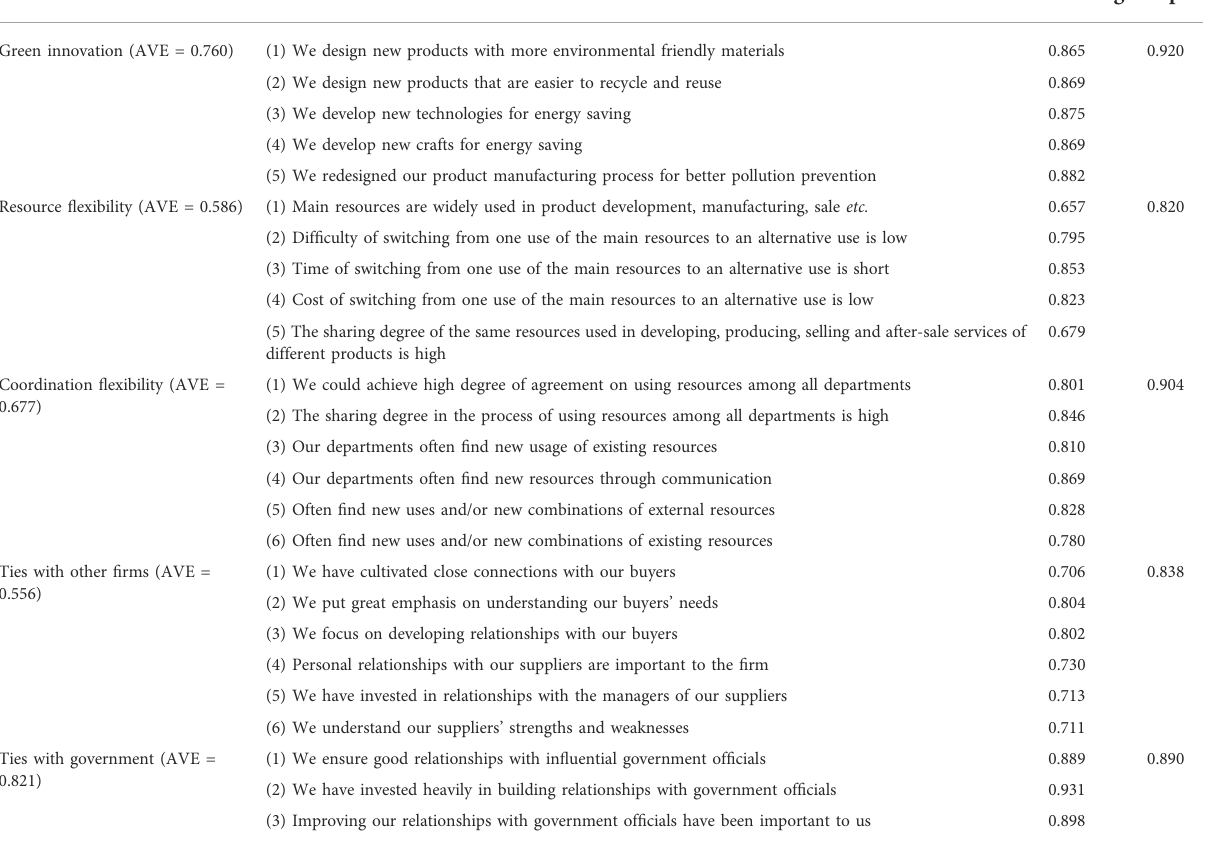
TABLE 1 Factor loadings and coef fi cient